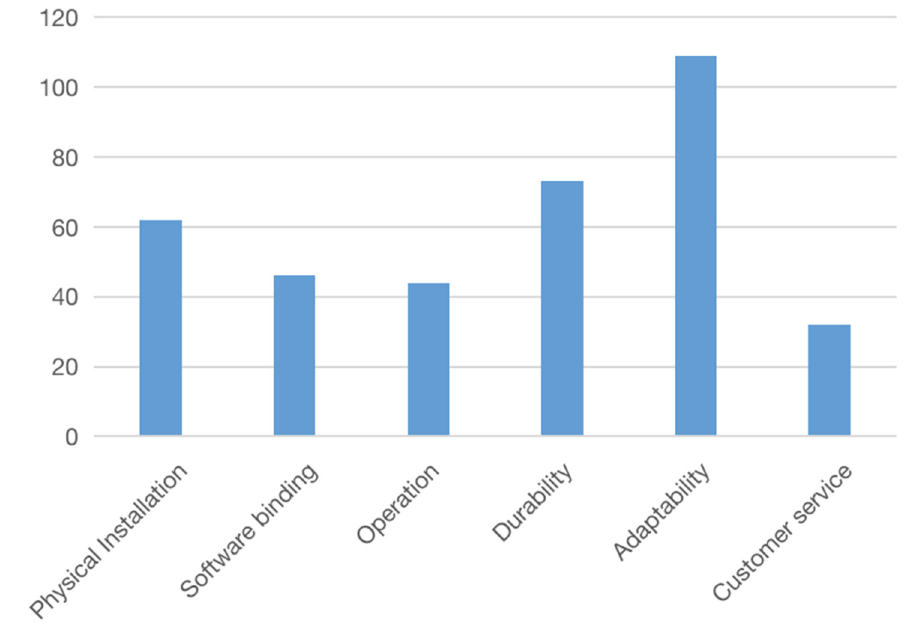
Figure 5. Competitiveness factors derived from GED samples.